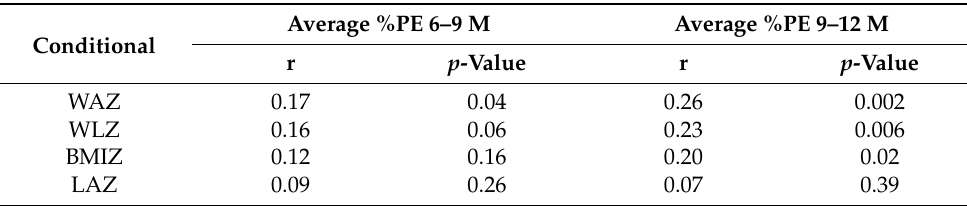
Table 4. Pearson’s correlations between protein intakes during two different periods (6–9 and 9–12 months of age) and conditional growth.